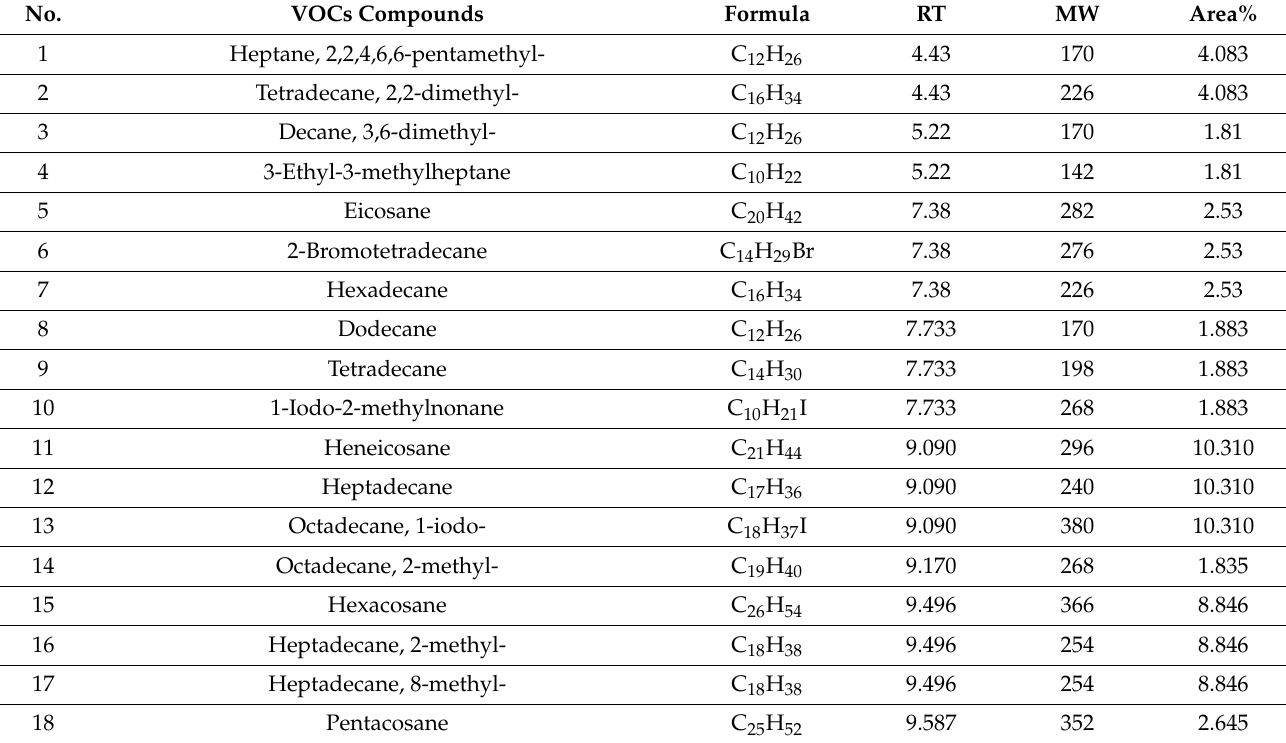
Table 2. GC-MS analysis of VOCs produced by S. arghel leaves extracted by